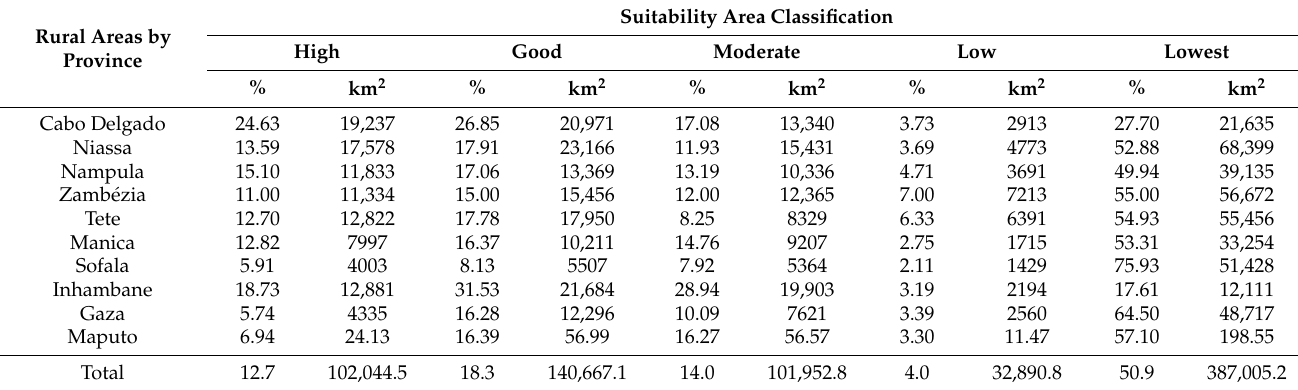
Table 9. Share of solar PV microgrid potential per suitability